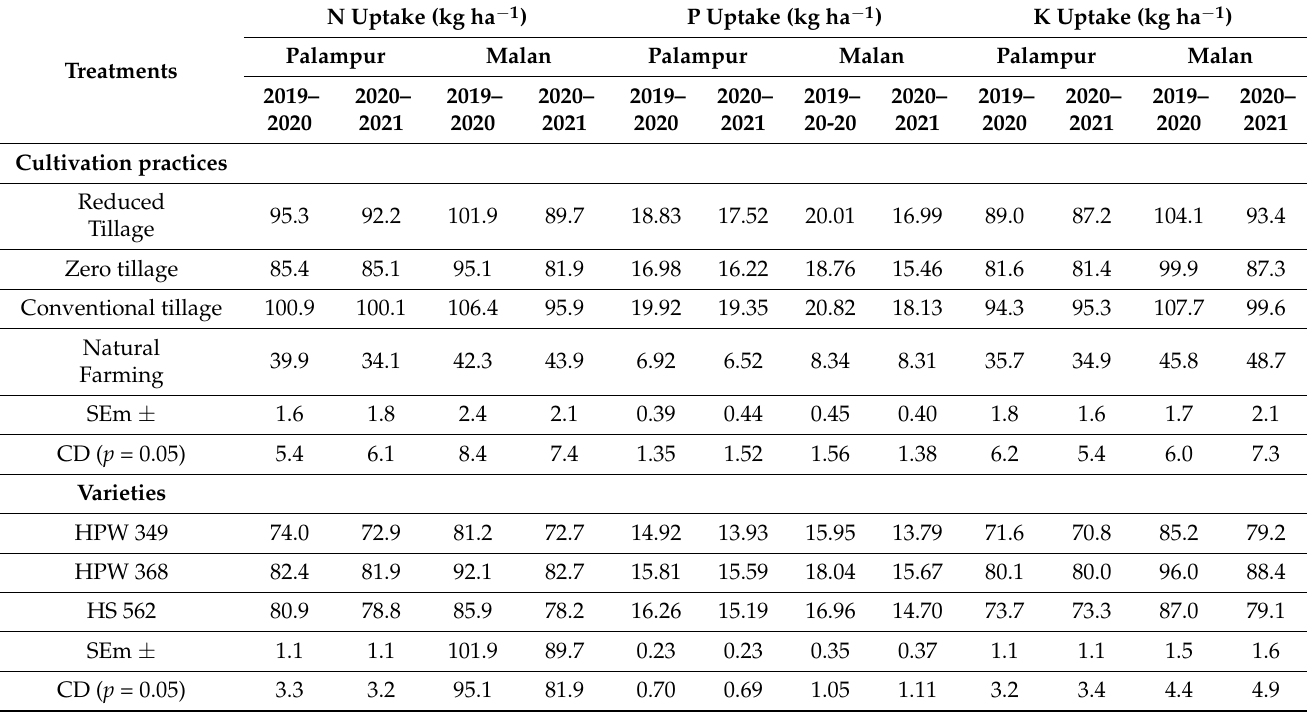
Table 5. Effect of cultivation practices on total N, P, and K uptake of different wheat varieties at Palampur and